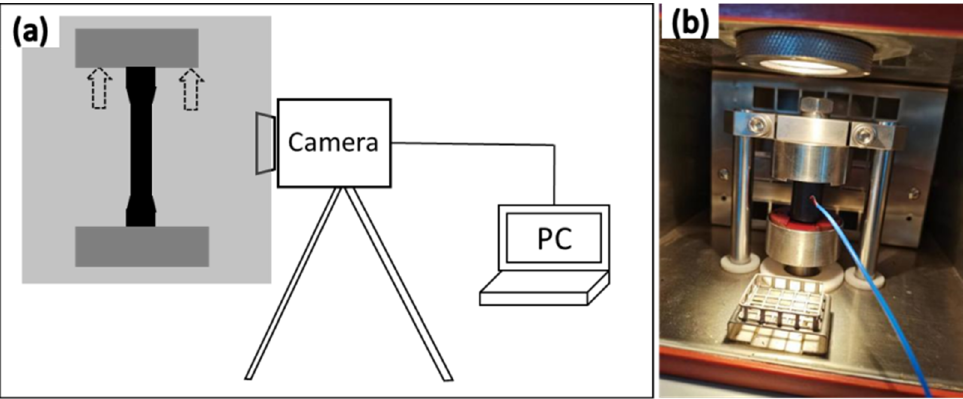
Figure 1. ( a ) Schematic diagram of infrared camera test. ( b ) Dynamic compression temperature rise experiment.